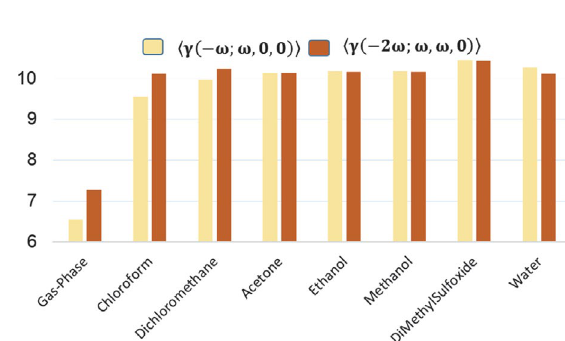
Figure 10: PCM-CAM-B3LYP/6-311++G(d,p) results for second hyperpolarizabilities (10 –36 esu ) ‹ γ (– ω; ω, 0, 0)› and ‹ γ (–2 ω; ω, ω, 0)›